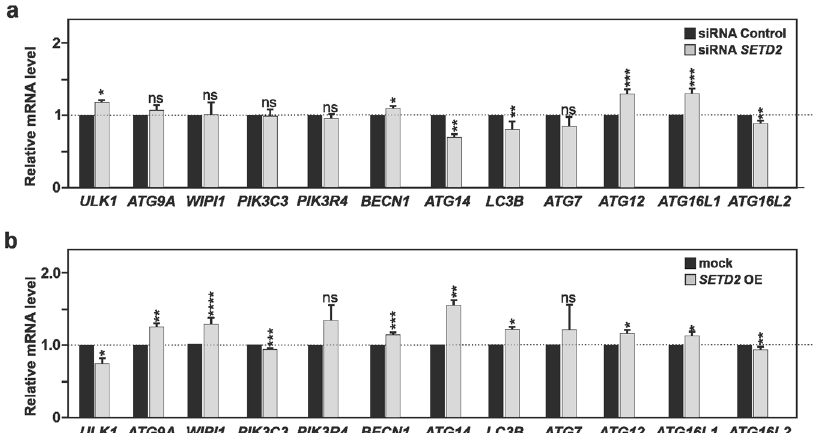
Fig. 3 Human SETD2 acts as a positive transcriptional regulator for the ATG14 and MAP1LC3B genes. a HeLa cells were transfected with a control non-targeting siRNA pool or SETD2 siRNA pool for 48 h. b HeLa cells were transfected with an expression vector encoding SETD2, or mock transfected with the corresponding pcDNA3.1 empty vector used as control, for 24 h. a , b Cells were harvested, total RNA extracted, and the expression level for several autophagy-related genes measured by RT-qPCR analysis. These gain- and loss-of-function analyses revealed the preferential regulation of MAP1LC3B/LC3B and ATG14 genes by SETD2. Bars display the mean of at least three independent experiments, error bars represent SEM; * P < 0.05; ** P < 0.01; *** P < 0.001; ns: non-signi fi